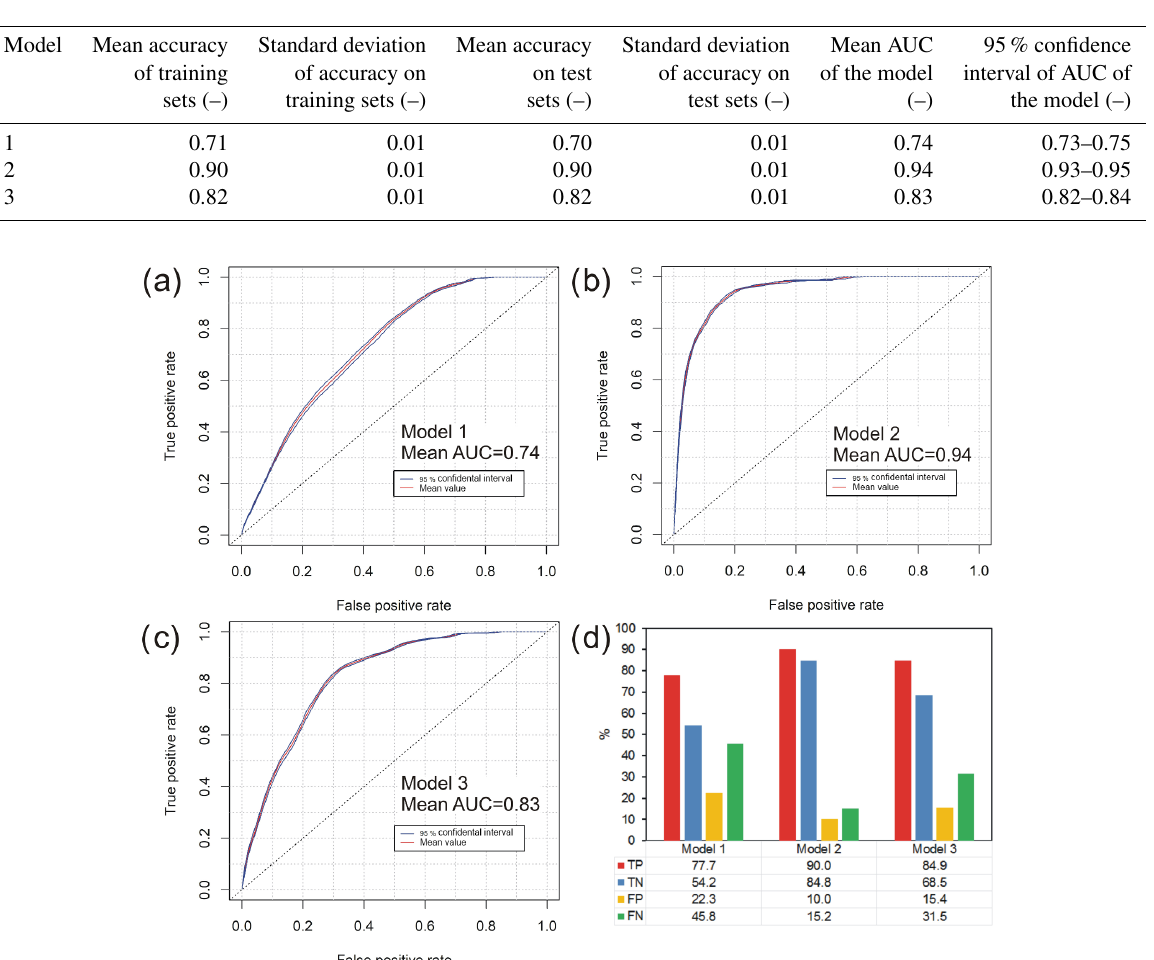
Figure 8. 95% bootstrap confidence bands of ROCs: (a) Model 1; (b) Model 2; (c) Model 3. (d) Percentage of true positives (TP), true negatives (TN), false positives (FP) and false negatives (FN) of the different